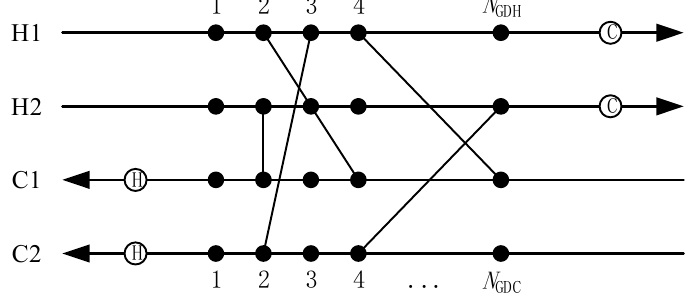
Figure 1. Sketch of the non-structural model.